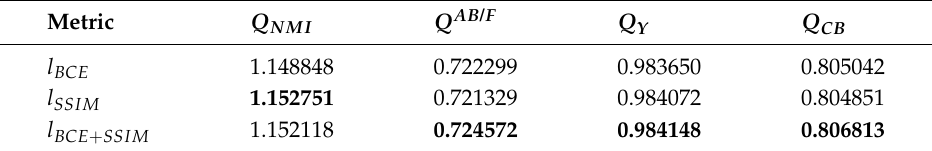
Table 3. The effectiveness of our hybrid loss function.